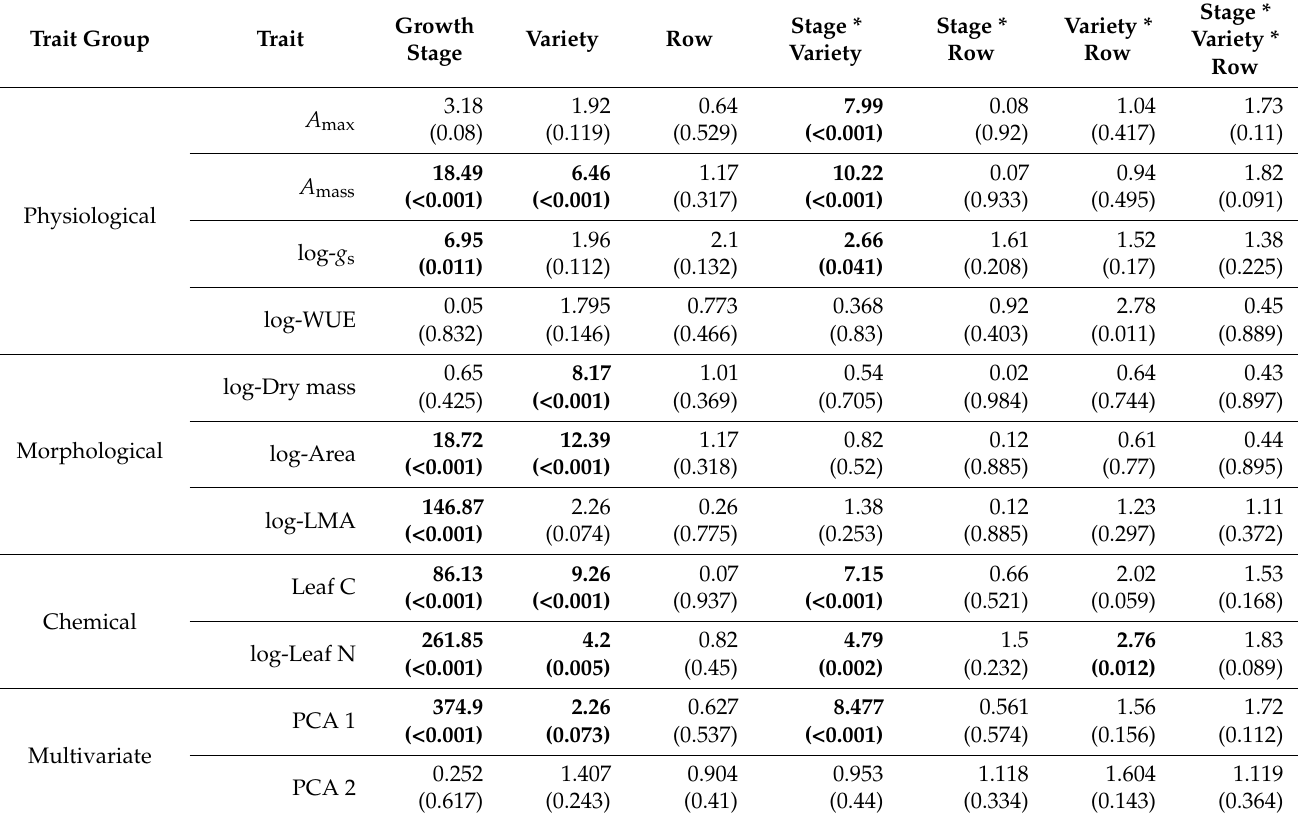
Table 2. Results of analysis of variance (ANOVA) testing variation in nine leaf traits and two principal components axis scores across two growth stages, five varieties, individual planting rows, as well as all two- and three-way interaction terms (denoted by